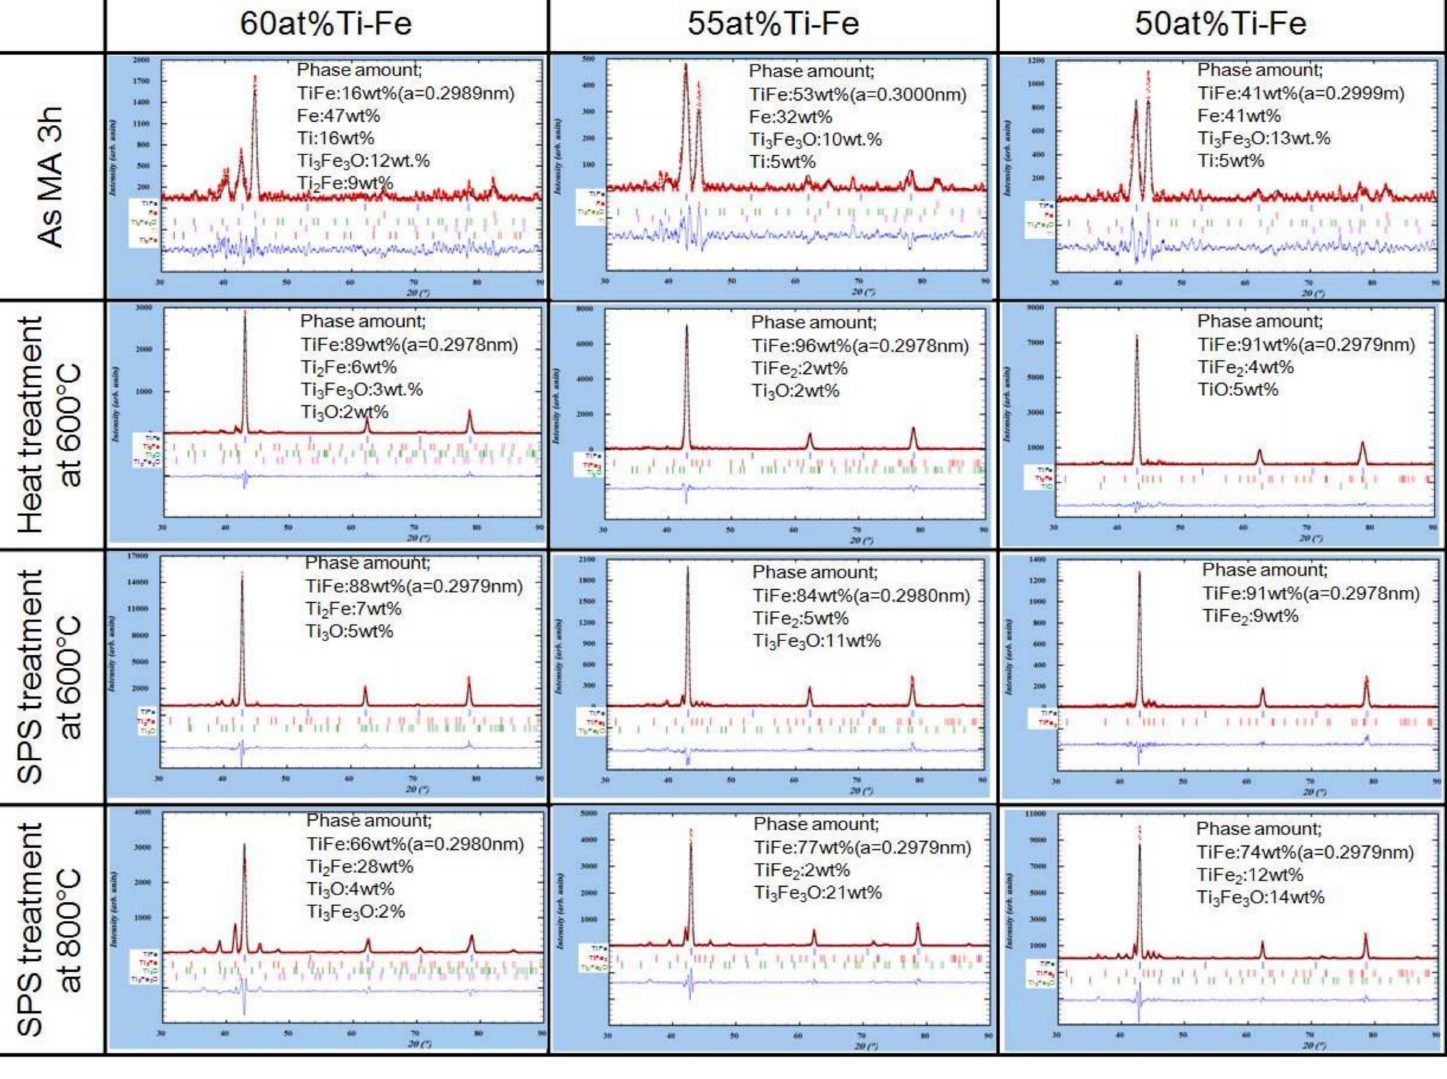
Figure 8. Rietveld analysis result for various Ti-Fe composition samples (Inset value; a: lattice parameter of TiFe phase, phase